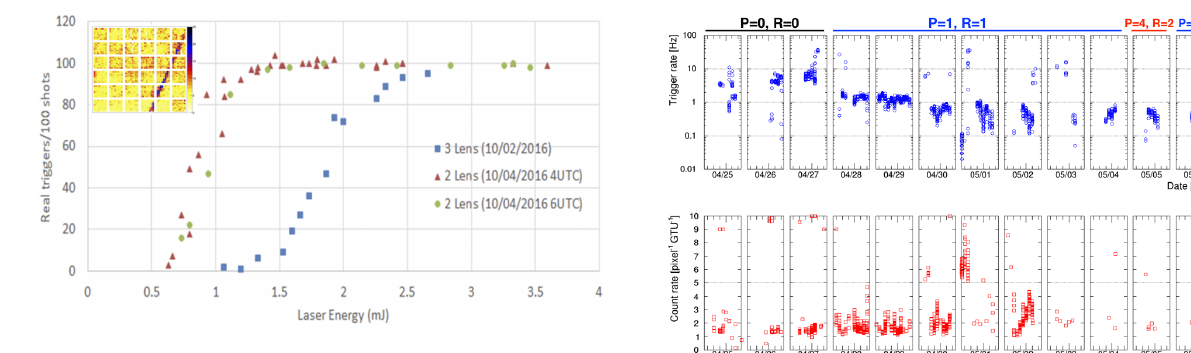
Figure 6. EUSO-SPB trigger e ffi ciency as a function of GLS en- ergy with 2 and 3 lens system for vertical shots during the field tests in Utah. An example of GLS track (2 mJ energy) is dis- played on the top-left corner.